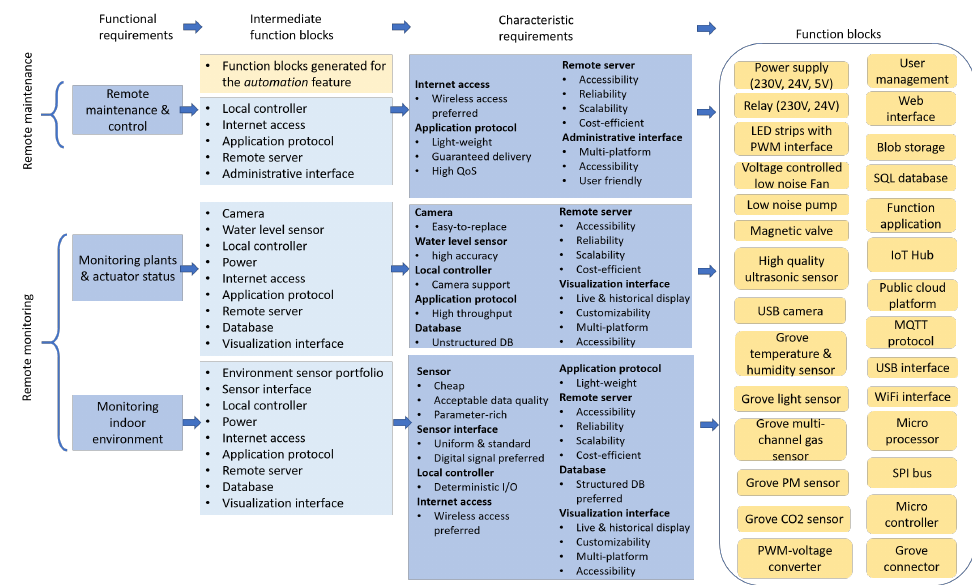
Figure 6. The remote monitoring and remote maintenance features are verified by functional and characteristic requirements and translated into a union of function